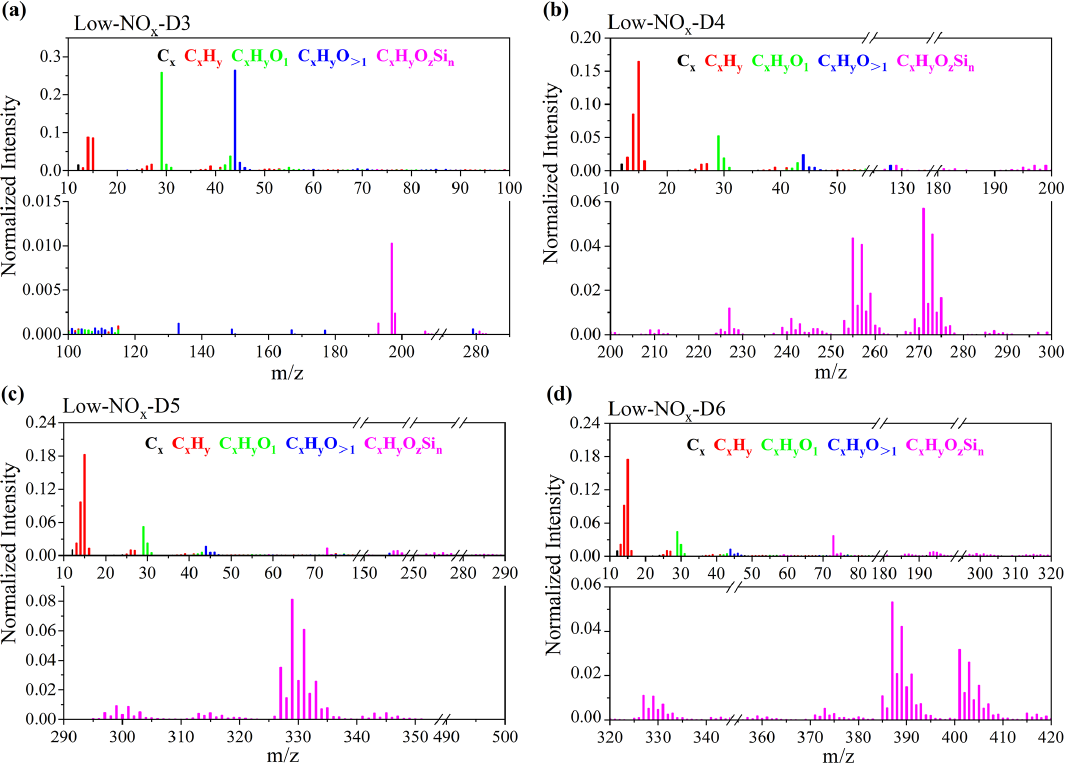
Figure 2. HR-ToF-AMS mass spectra of cVMS SOAs at OH exposure of 9 . 0 × 10 11 moleculescm − 3 s (i.e., OH concentration of 7 . 5 × 10 9 moleculescm − 3 ) under low-NO x conditions in unseeded experiments. Panels (a) – (d) represent the mass spectra of D3–D6 SOAs,